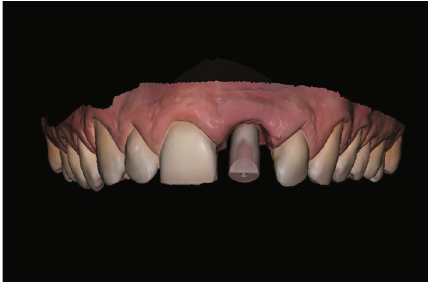
Figure 14: Intraoral scan with a scanbody screwed onto the implant.